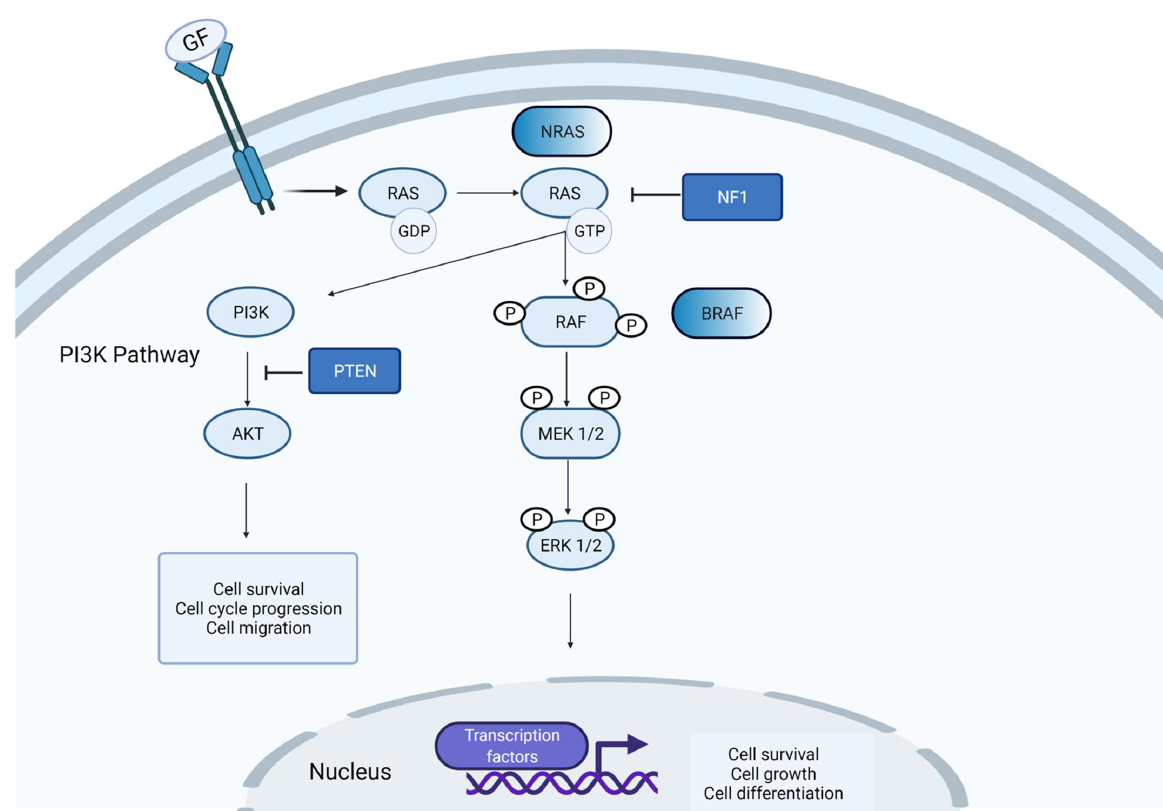
Figure 1. Schematic of cellular events in the MAPK pathway. MAPK signalling can be initiated by receptor tyrosine kinases (RTKs). Once activated, the RTKs stimulate downstream signalling by RAS, RAF and MEK and ERK, finally resulting in activation of several transcription factors in the nucleus. RAS-GDP is also involved in PI3K signalling through AKT activation.